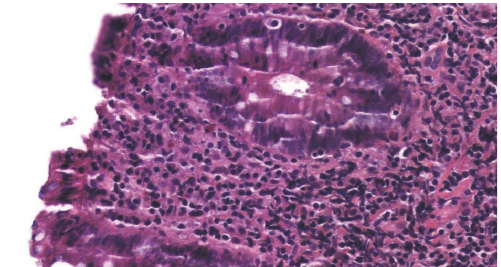
Figure 2: Marked small lymphocytic infiltrate obscuring normal colon architecture.